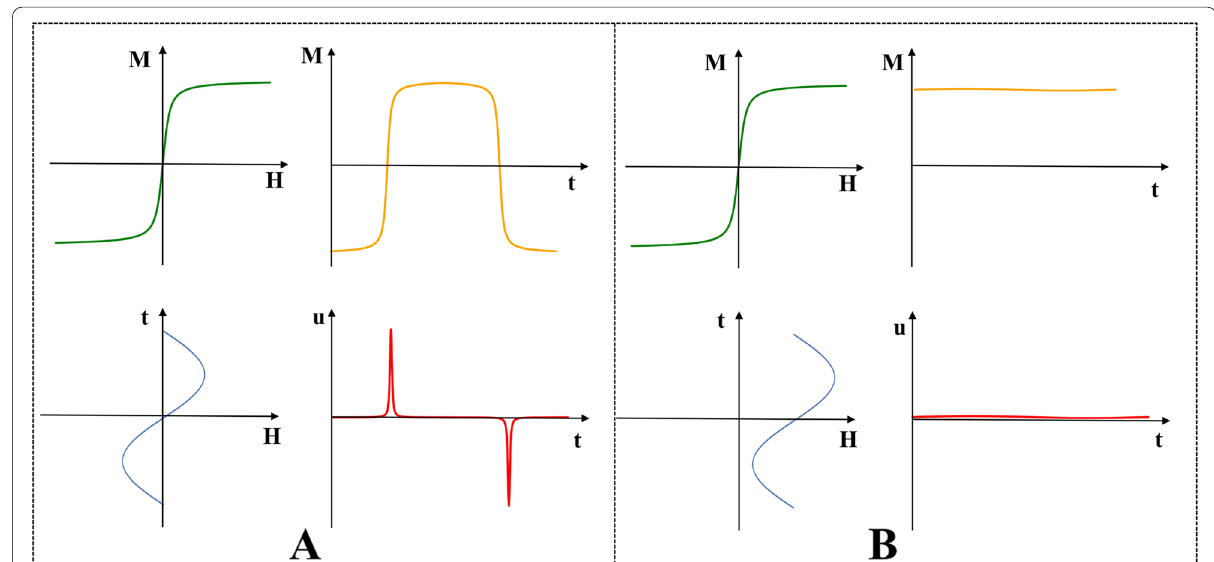
Fig. 1 Magnetization response of SPIOs. A SPIOs are excited with a sinusoidal magnetic field. B SPIOs enter the magnetized saturation